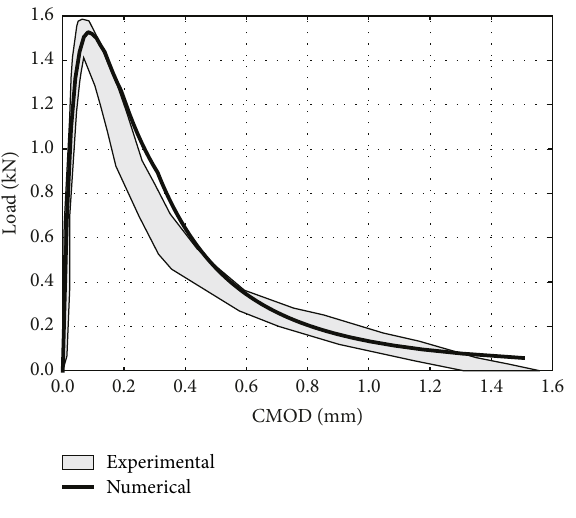
Figure 11: CFR concrete. Figure 12: CCR